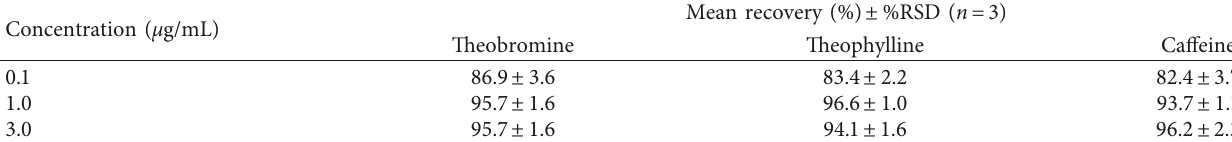
Table 5: Recovery and repeatability of the proposed analytical method at three different spiking levels.